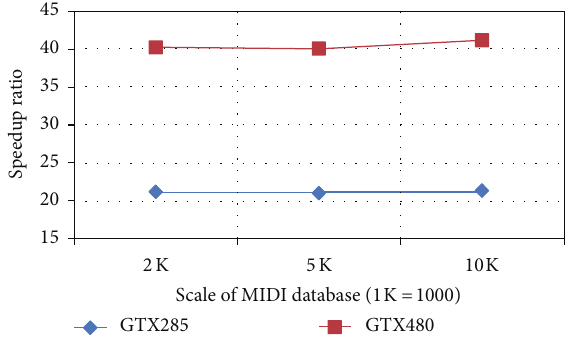
Figure 3: Speedup ratio obtained with the usage of GPUs.